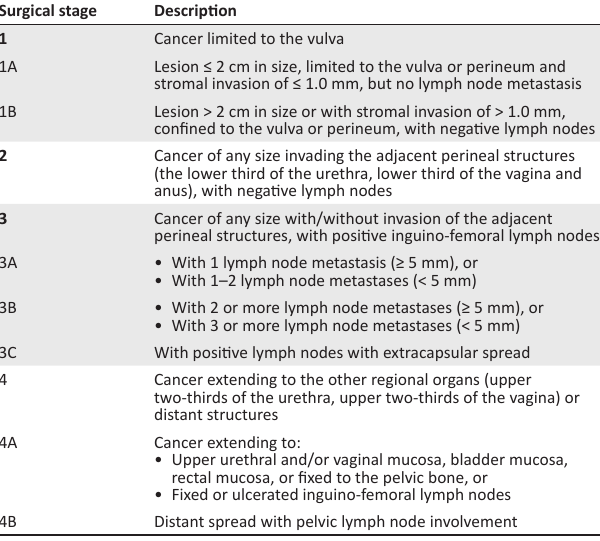
TABLE 1: International Federation of Gynaecology and Obstetrics surgical staging of vulvar